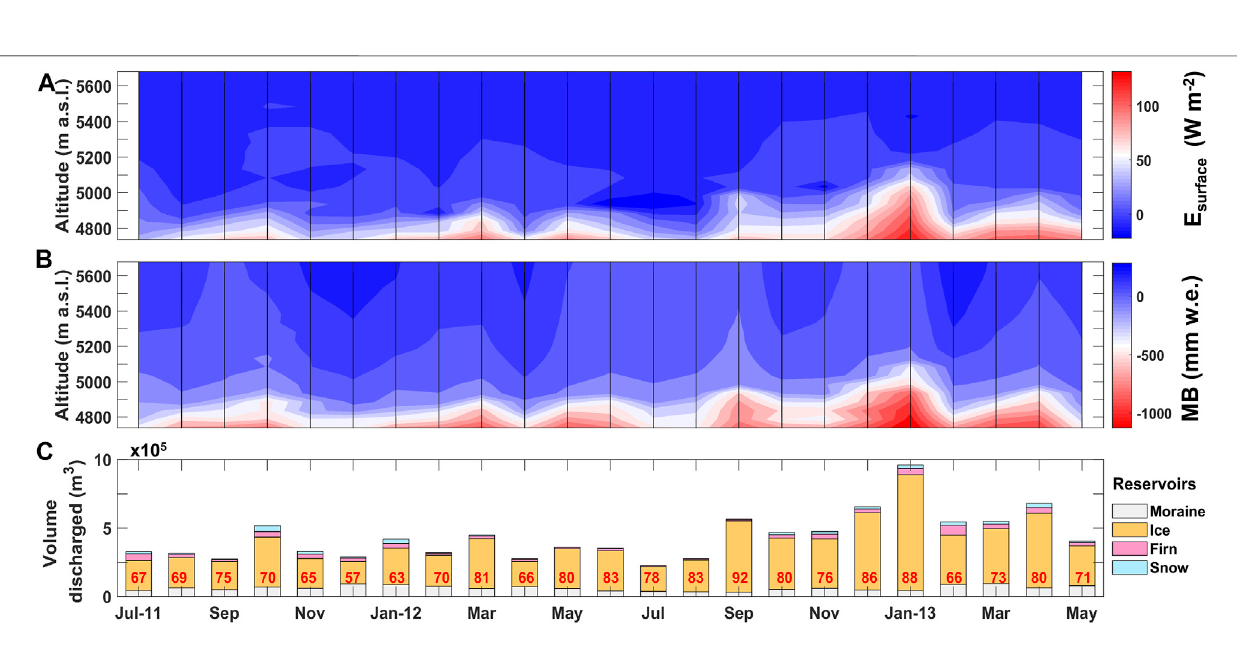
Frontiers in Earth Science |